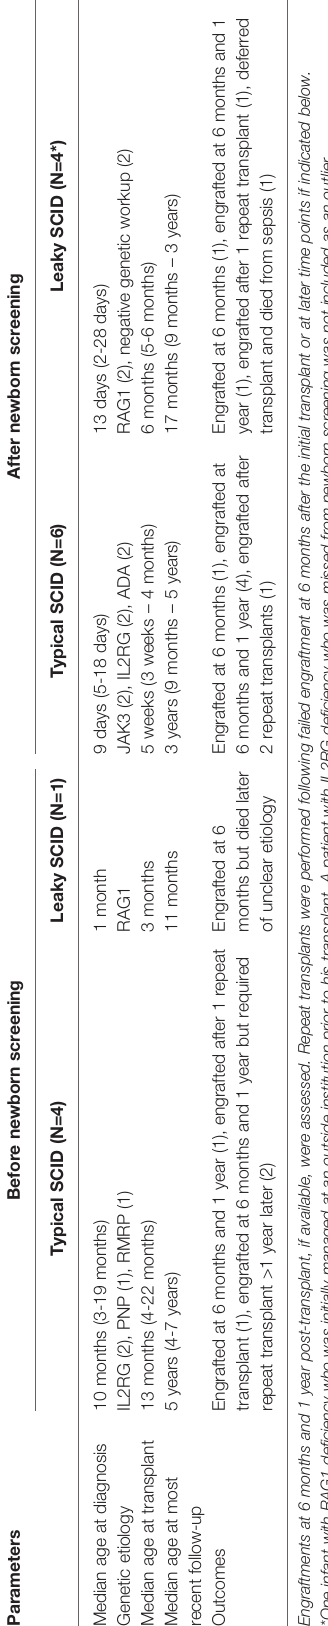
Patients with undetectable or 0 TREC copies were excluded from the